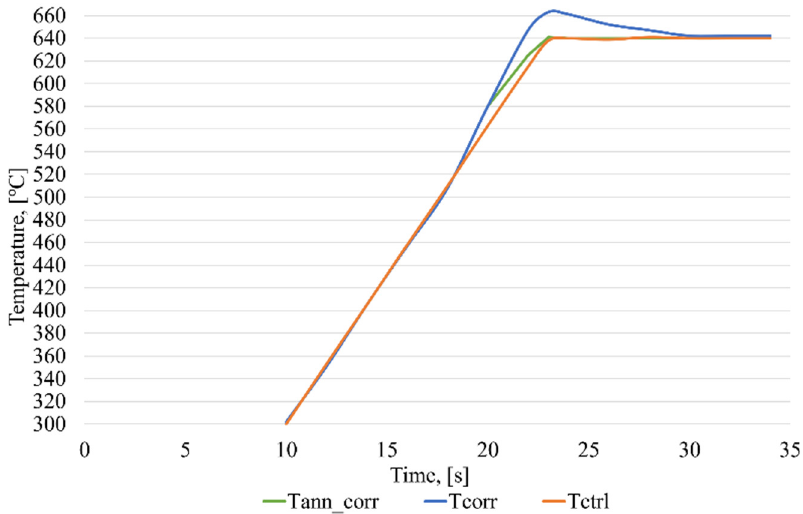
Figure 20. Graph of the intelligent control of the induction brazing process in the case of correcting the measurements from one of the pyrometers, where Tcorr—temperature values obtained from a correcting pyrometer, Tctrl—temperature values obtained from a control pyrometer, and Tann_corr—temperature values corrected using ANN corr .